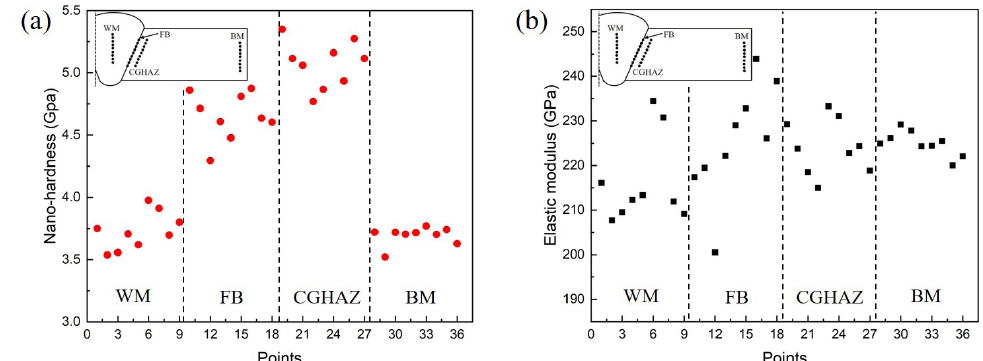
Figure 10. Nano hardness and elastic modulus